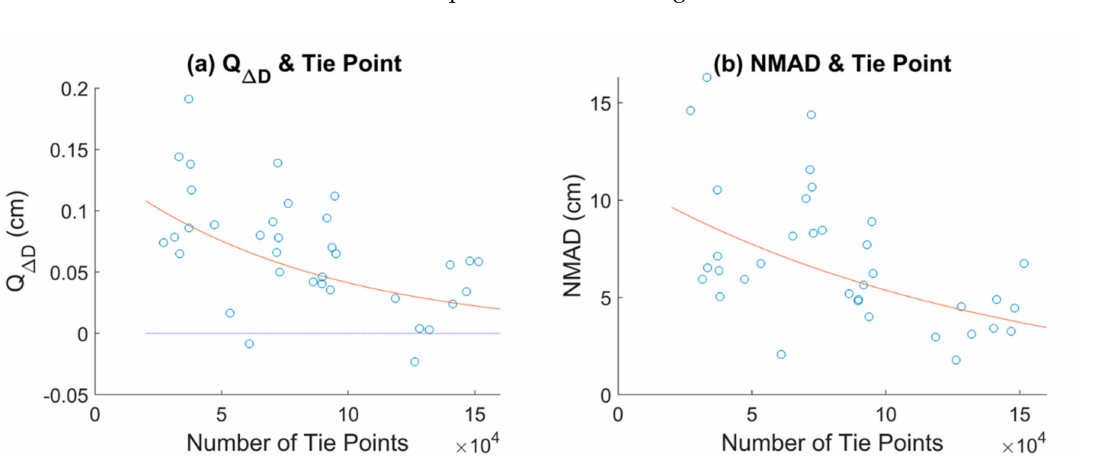
Figure 9. ( a ) Relationship between the number of tie points (x) and Q ∆ D of estimated snow depths (y). ( b ) Relationship between number of tie points (x) and NMAD of the estimated snow depths